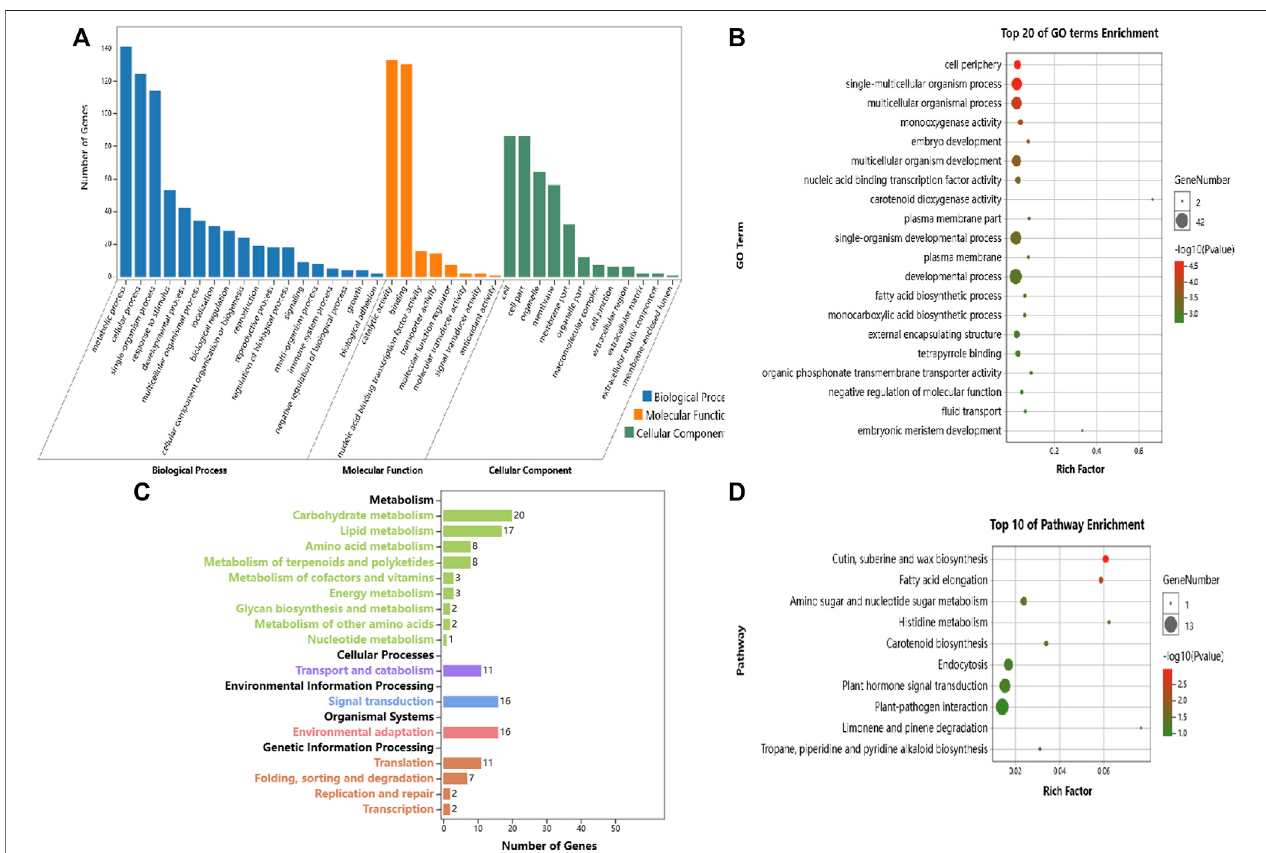
FIGURE 10 | GO and KEGG enrichment analysis of the DEGs that are due to the different environmental conditions at Daqing and Qiqihar. (A) . GO annotation analysis of DEGs due to environmental conditions, (B) . Top 20 GO Term enrichment of DEGs due to environmental conditions, (C) . KEGG enrichment analysis of DEGs due to environmental conditions; (D) . Top 10 Pathway enrichment of DEGs due to environmental